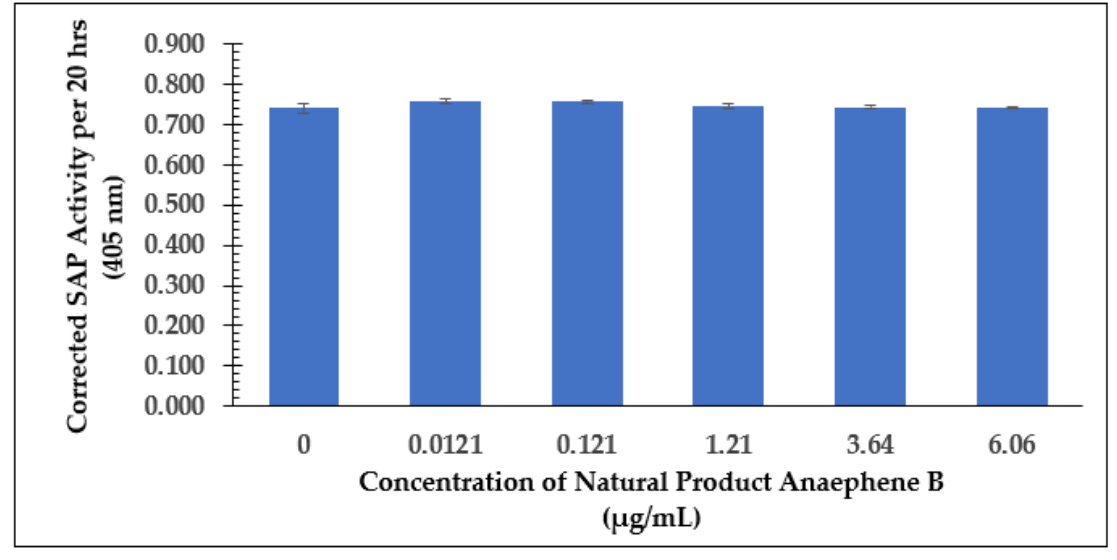
Figure 12. SAP Assay Following Dose-Dependent Study of Anaephene B—Senescence Phase (Cell Culture Age: 648 h). Values are the mean and standard deviation for n = 3 replicates.